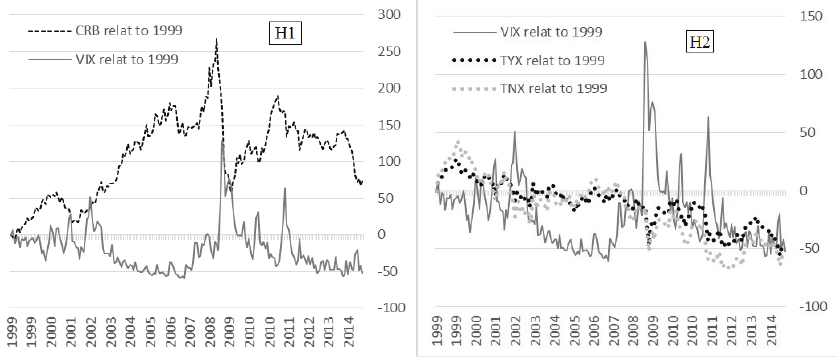
Fig. 5 – Plotted monthly returns (relative to 1999) of selected U.S. leading market indices- TR/J CRB, VIX, TYX and TNX; over the period 04 January 1999 till 01 April 2015 (in %, 100=1999). Source: Own